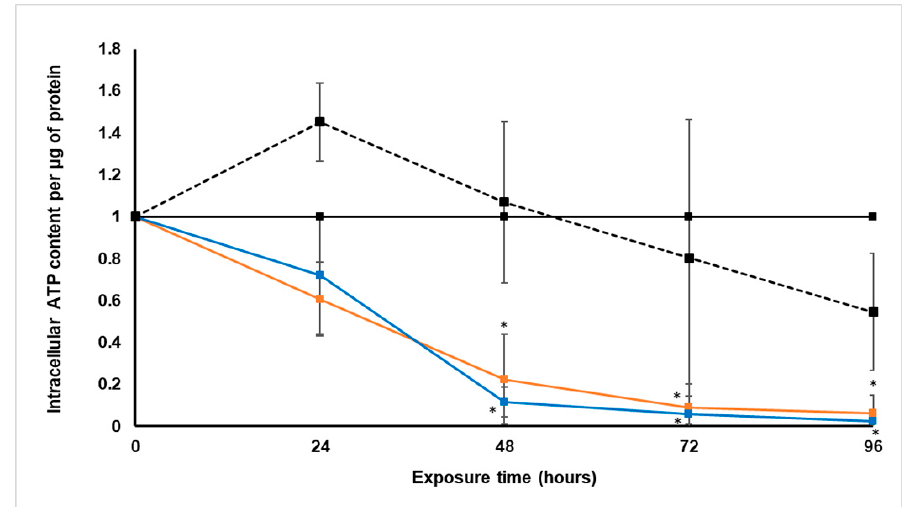
Figure 7. Normalized intracellular adenosine triphosphate content per soluble protein (µM·µg − 1 ) following exposure of the sodium alginate encapsulated LS180 mini-tumor model to Xysmalobium undulatum aqueous extract and paclitaxel. The solid black line represents the untreated control, the black dashed line represents paclitaxel [IC 50 ], the orange line represents X. undulatum [IC 50 ] and the blue line X. undulatum 2[IC 50 ]. All data were normalized to the untreated control group (error bars = standard deviation; n = 6; * = statistically significant, p < 0.05 (one-way ANOVA followed by the Dunnett post-hoc test).